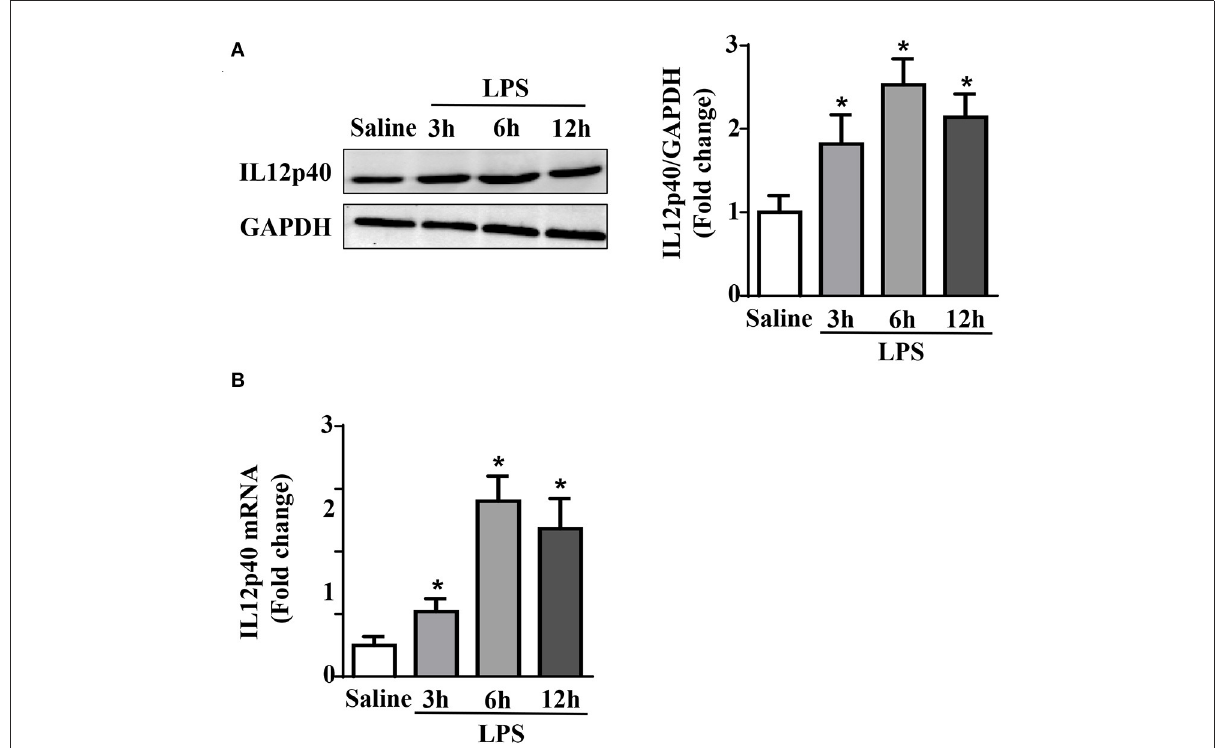
FIGURE1 LPS treatment increases cardiac IL-12p40 expression in mice. (A) Western blot analysis of IL-12p40 protein levels in the hearts of each group ( n = 5). (B) qRT-PCR analysis of IL-12p40 mRNA expression levels in the hearts of each group ( n = 6). * P < 0.05 compared with the Saline